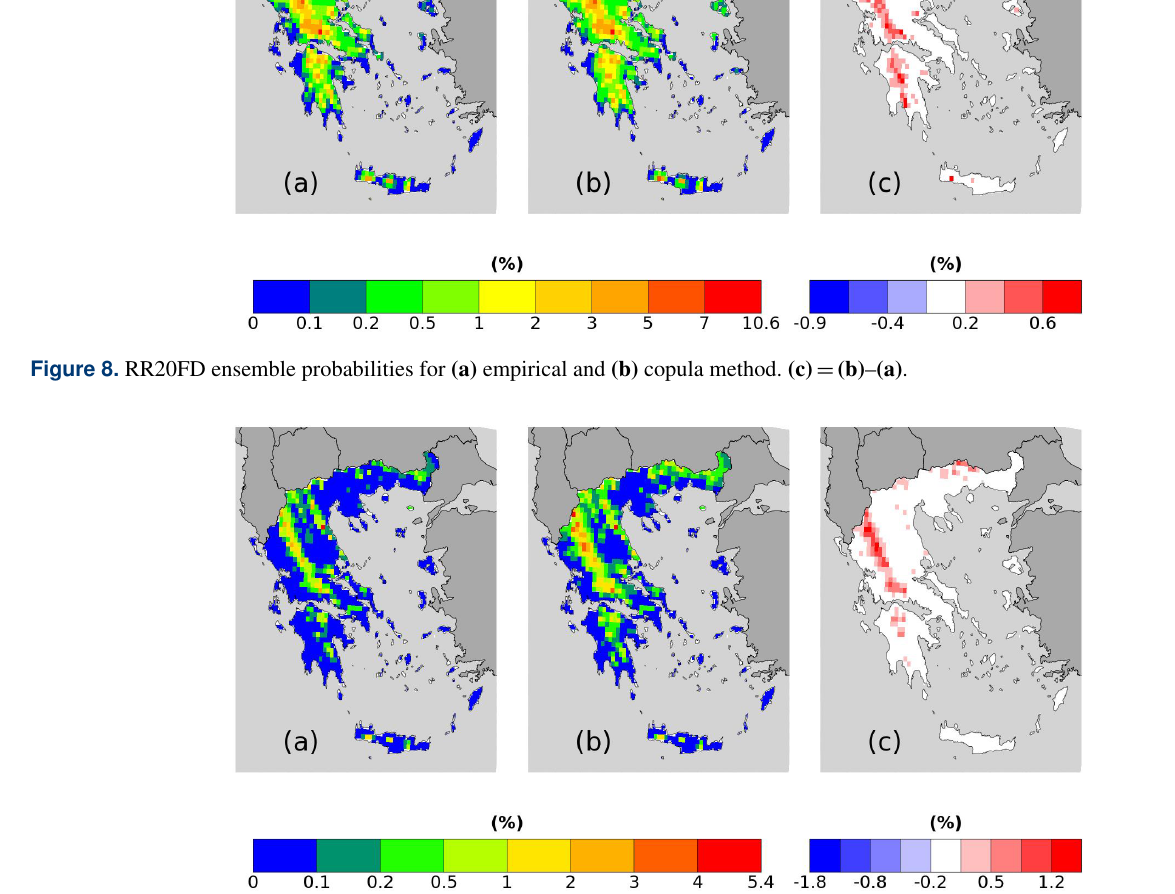
Figure 9. RR20ID ensemble probabilities for (a) empirical and (b) copula method. (c) = (b) – (a)